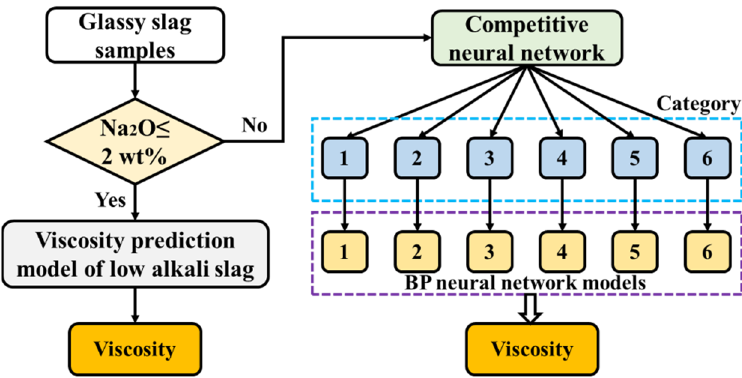
Figure 4. Slag categorization and high accuracy prediction route of